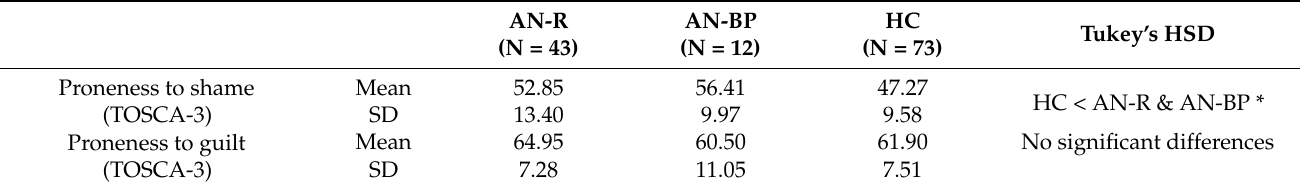
Table 4. Shame and guilt in AN Subtypes. Post hoc test.